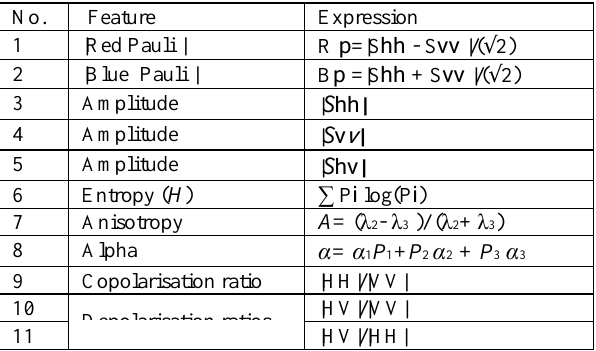
Table 2. Polarimetric parameters considered in this work